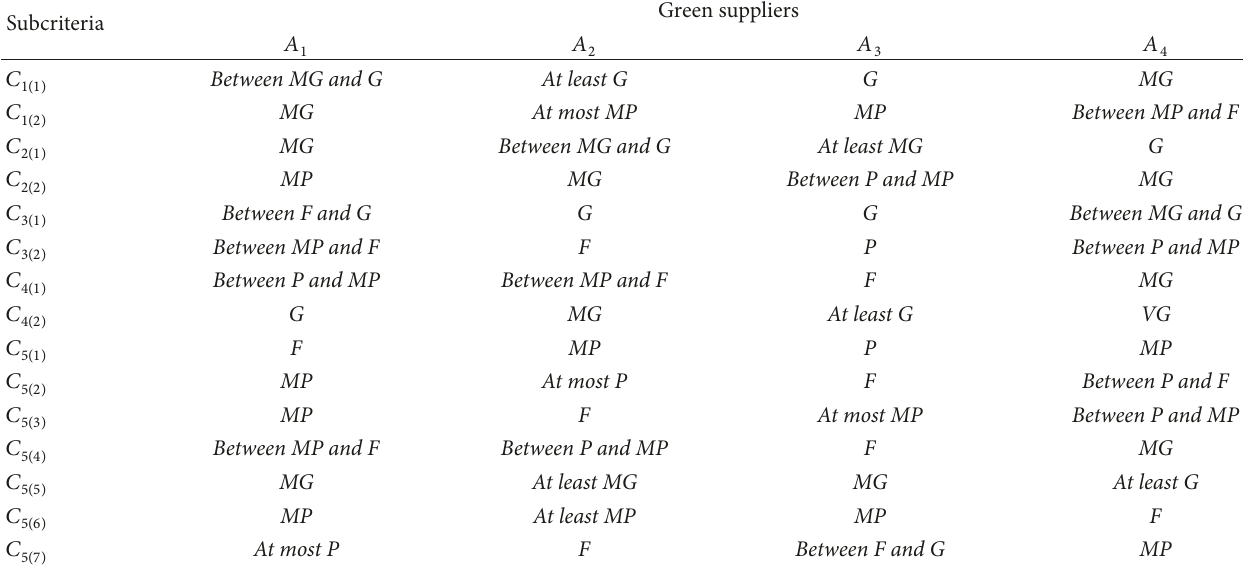
Table 2: The FLE evaluation results of green suppliers in food supply chain.